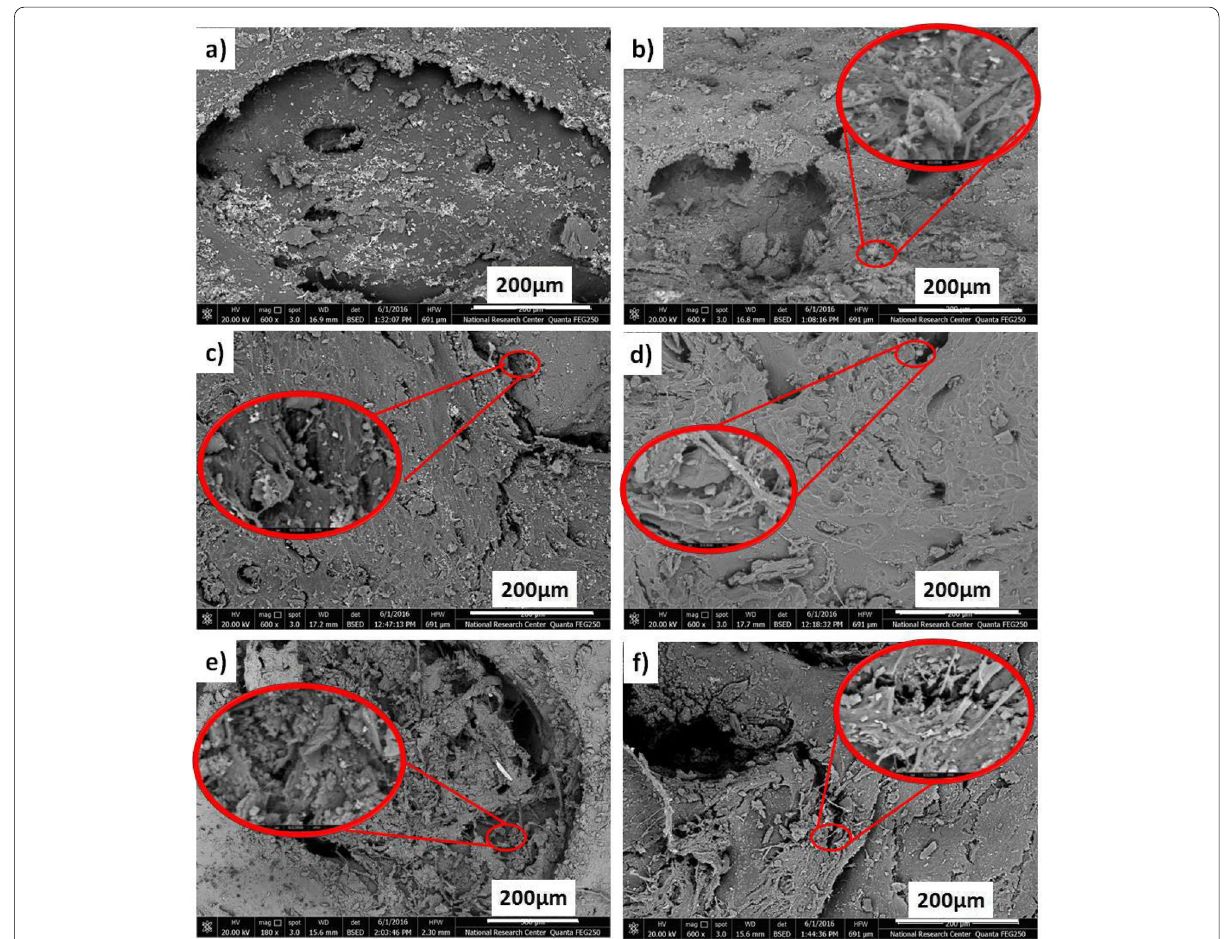
Fig. 9 SEM images for post‑implantation ceramic nanocomposite. C1, a and b ; C2, c and d ; and C3, e and